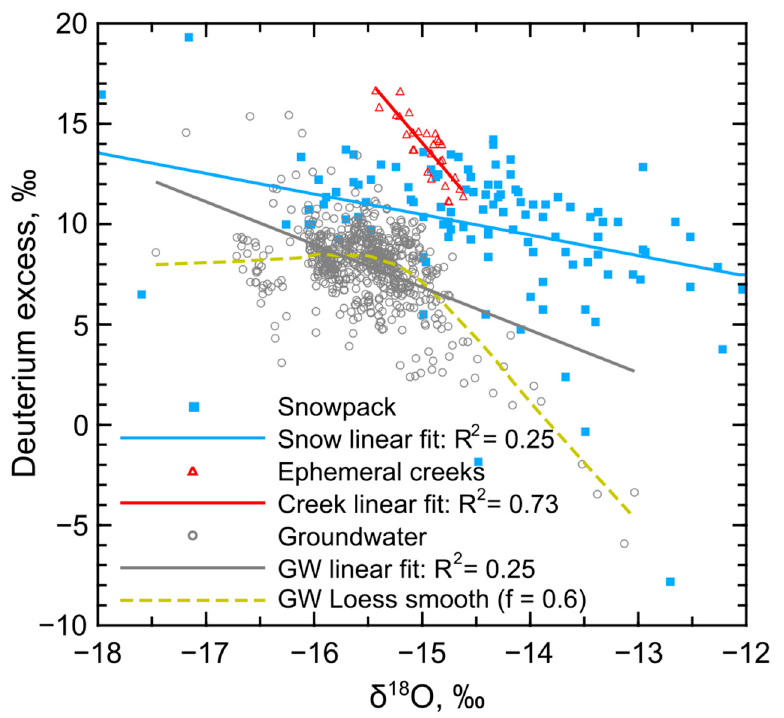
Figure 12. Deuterium excess and δ 18 O in source waters and groundwater in the South Fork Palouse River